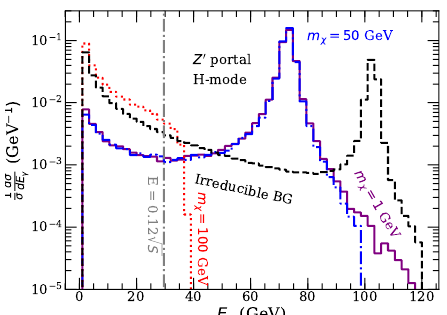
Figure 11 . Normalized E (cid:13) distribution at the CEPC H -mode, in the Z 0 portal model, as well as in the SM irreducible background process. Only the vector couplings are considered, i.e., g (cid:31) and g f = 0. We use g (cid:31) = 1, g f = 0 : 01, and M Z 0 = 150 GeV for the Z 0 portal model. For the A V V